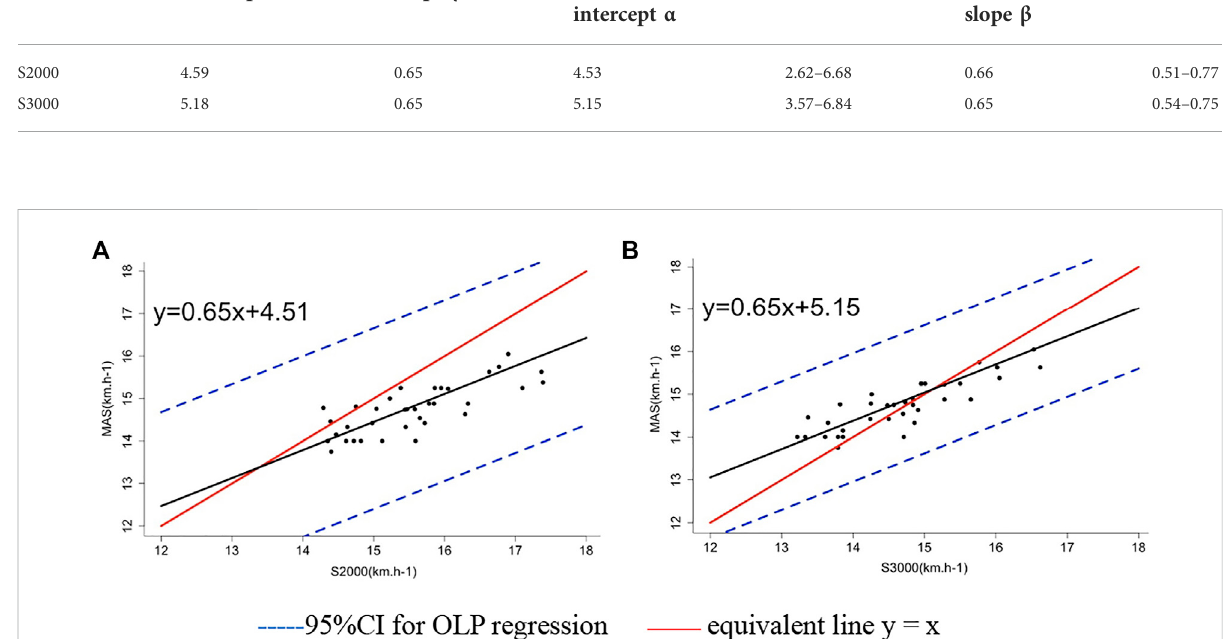
FIGURE 1 Ordinary least product (OLP) regression of the MAS on S2000 and S3000: the S2000 average speed of 2,000 m TT and the S3000 average speed of 3,000 m TT. (A) OLP regression of the MAS on S2000 (B) OLP regression of the MAS on S3000.